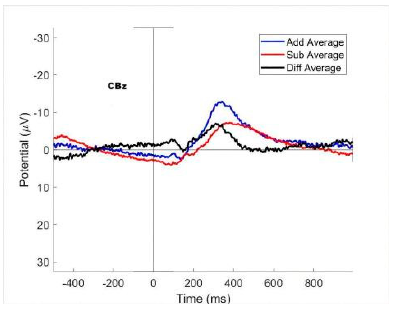
Figure 10. Cerebellum region CBz waveform comparison of multiple subjects.